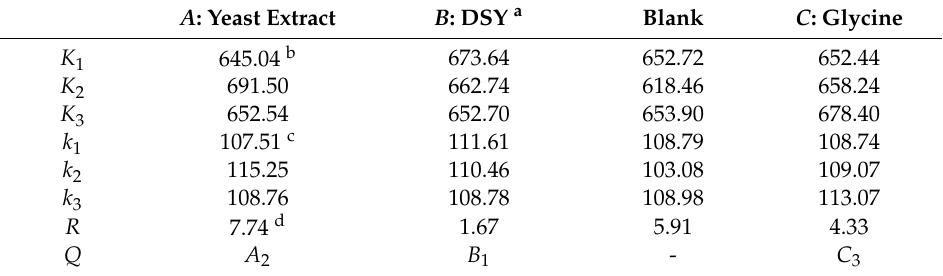
Table 2. The range analysis of L 9 (3 4 ) orthogonal experimental runs of ethanol concentration. A : Yeast Extract B : DSY a Blank C : Glycine K 1 645.04